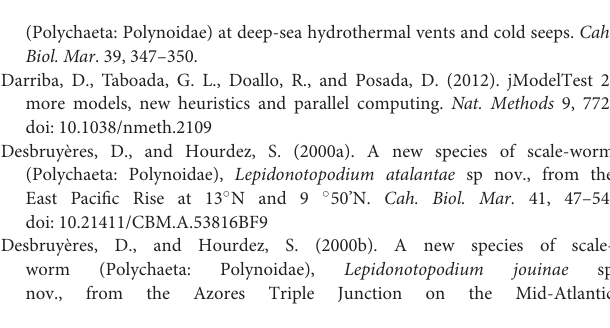
Supplementary Figure 2 | Phylogenetic tree constructed using the concatenated sequences of four genes ( COI , 16S , 18S, and 28S ) by the ML and MP methods. Numbers above branches represent ML/MP bootstrap values with 100 as the highest value. The sequences of the two new species were generated in this study. The sequences of Branchinotogluma japonicus and Lepidonotopodium okinawae are from Zhang (2017). The sequences of the other species are from Gonzalez et al.